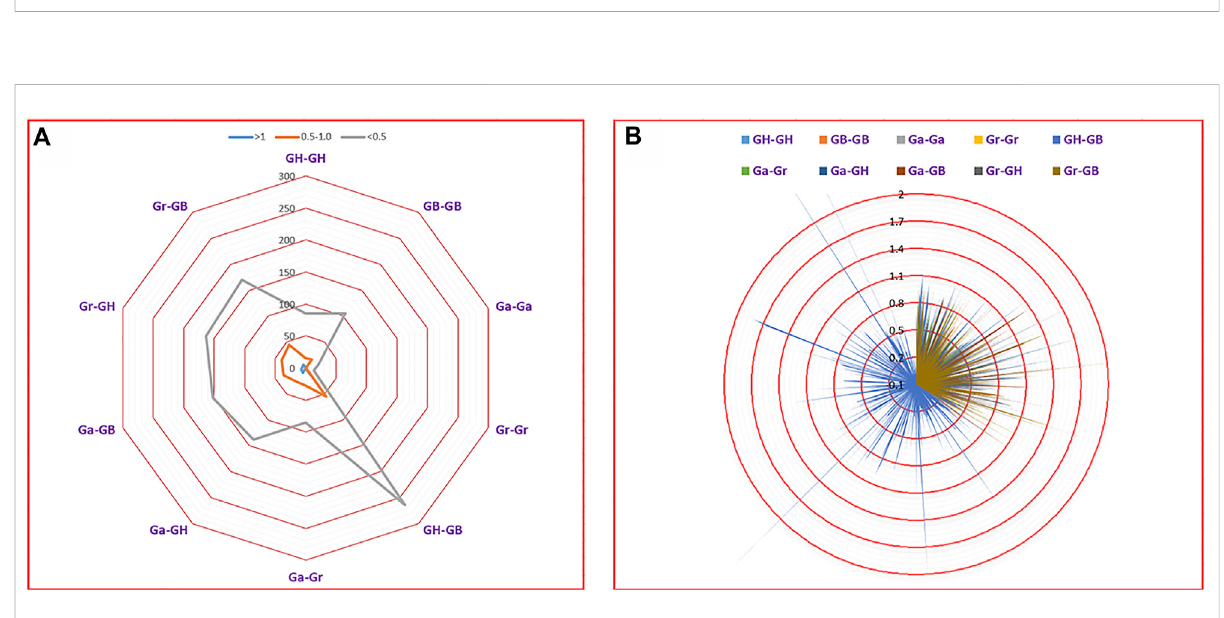
FIGURE 8 Selection pressure analysis based on Ka/Ks. (A) Number of duplicate gene pairs in different genomes of four cotton species. (B) Ka/Ks divergence values for GH-GH, GB-GB, Gr-Gr, Ga – Ga, GH-GB, Ga-Gr, Ga-GH, Ga-GB, Gr-GH and Gr-GB are displayed in a circular